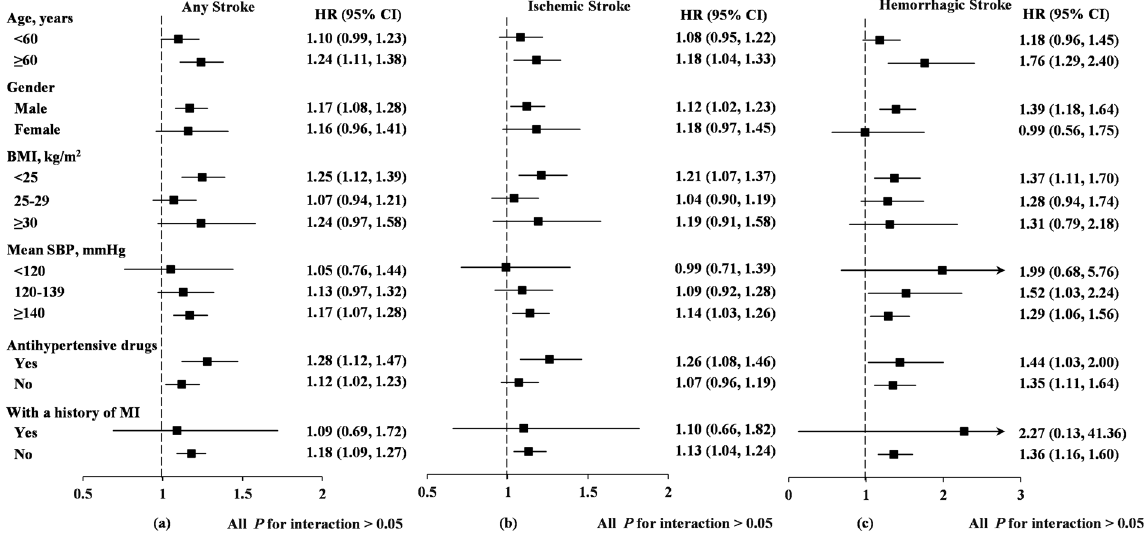
Figure 1. Hazard ratios for stroke outcomes associated with per SD increases in the CV of SBP in selected subgroups. Data were adjusted for age, gender, body mass index, current smoking, current drinking, education level, income level, physical activity, heart rate, diabetes mellitus, dyslipidemia, serum uric acid, high-sensitivity C-reactive protein after logarithmic transformation, history of MI, family history of stroke, and the use of antihypertensive drugs, mean of systolic blood pressure and mean of diastolic blood